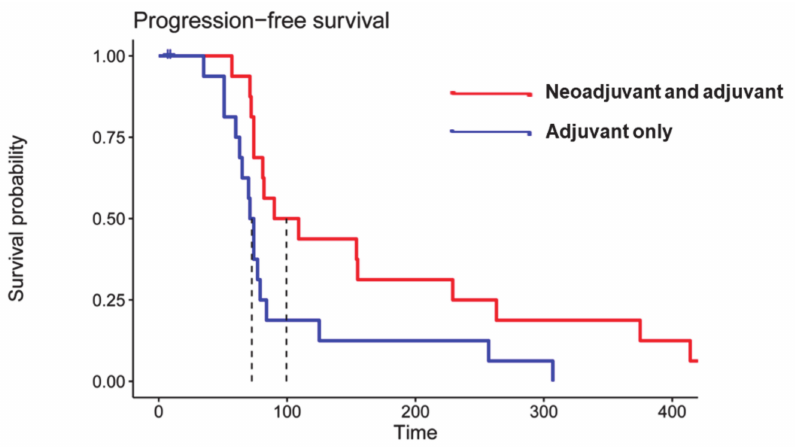
Figure 3. Kaplan–Meier curves showing significantly prolonged progression-free survival (PFS) in patients who received neoadjuvant and adjuvant pembrolizumab (median PFS = 72.5 days, red curve) compared to patients who received pembrolizumab only in the adjuvant setting (blue curve) (median PFS= 99.5 days, two-sided p = 0.03 by log-rank test). Reprinted with permission from ref. [49]. Copyright 2019 Springer Nature America,